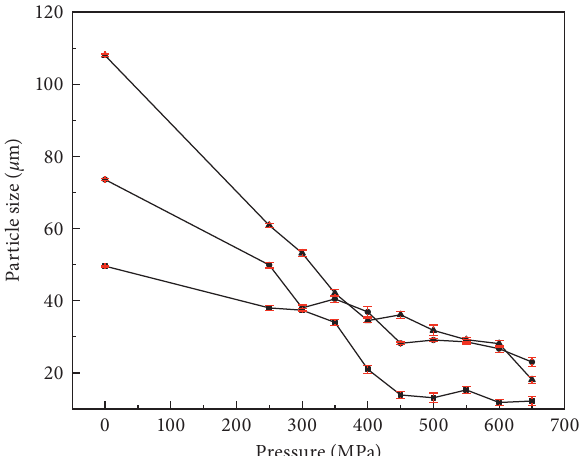
Figure 7: Decrease in average particle size of TiH 2 powder after compaction depending on pressure. — ■ —38–63 μ m, — ● —63–88 μ m, and — ▲ —88–125 μ m.